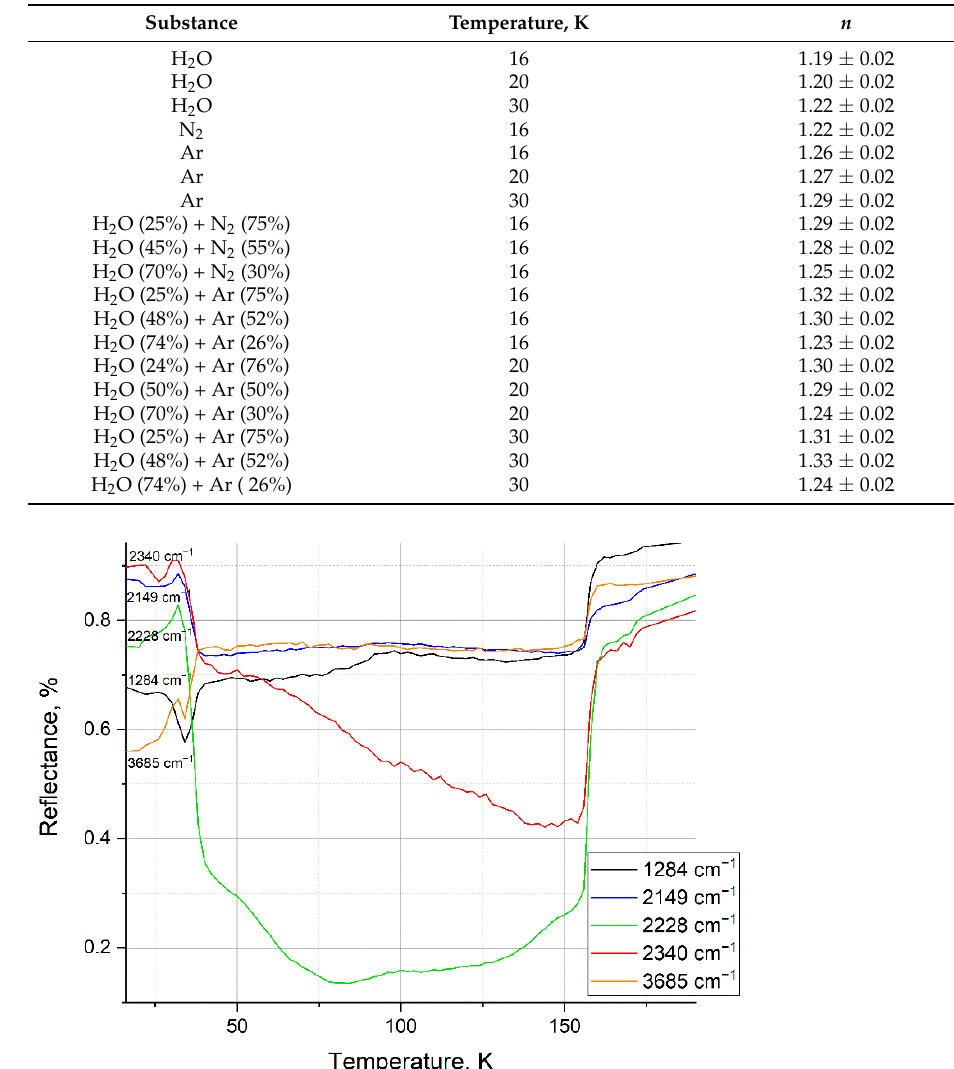
Table 1. Dependence of the refractive index (RI) on mixture concentrations and deposition temperature.